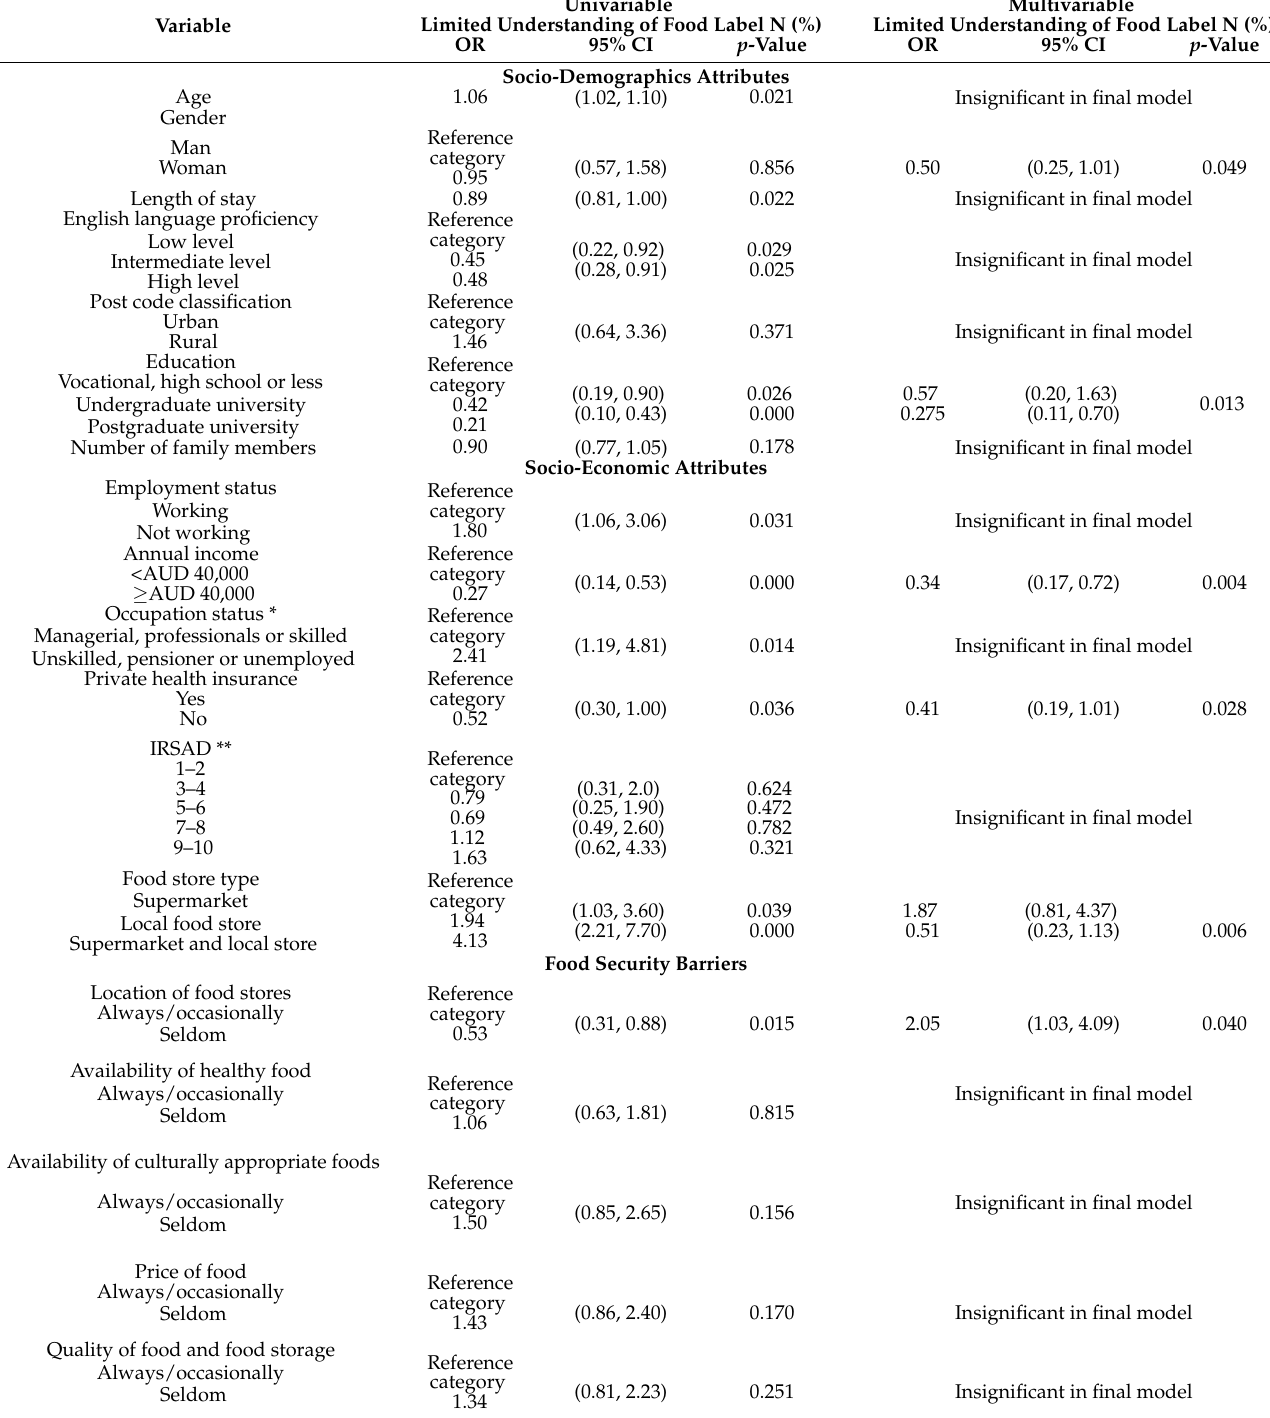
Table 2. Univariable and multivariable logistic regression for the understanding of food labels—odds ratio (OR) and 95% confidence interval